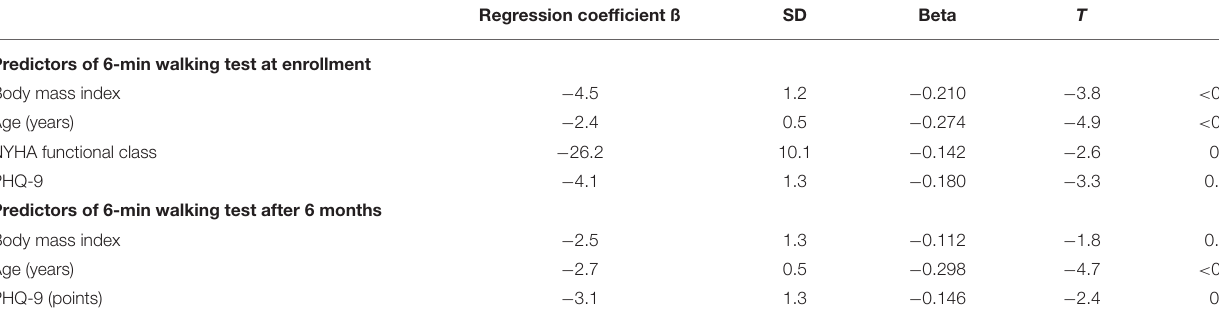
TABLE 4 | Overview of the results of regression analysis (BACKWARD method) regarding 6-min walking test.